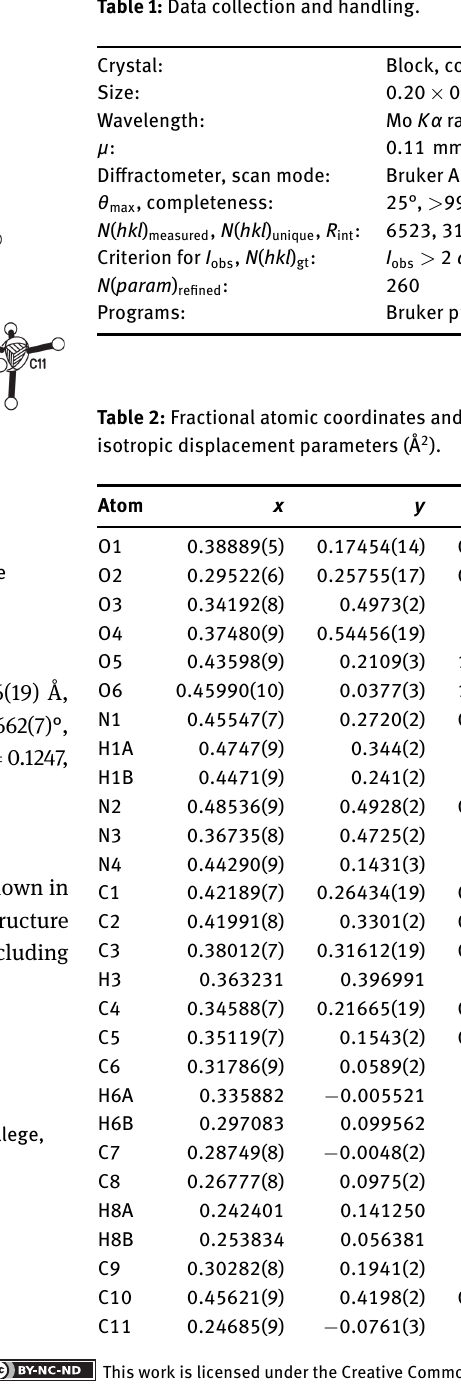
Table 1: Data collection and handling.